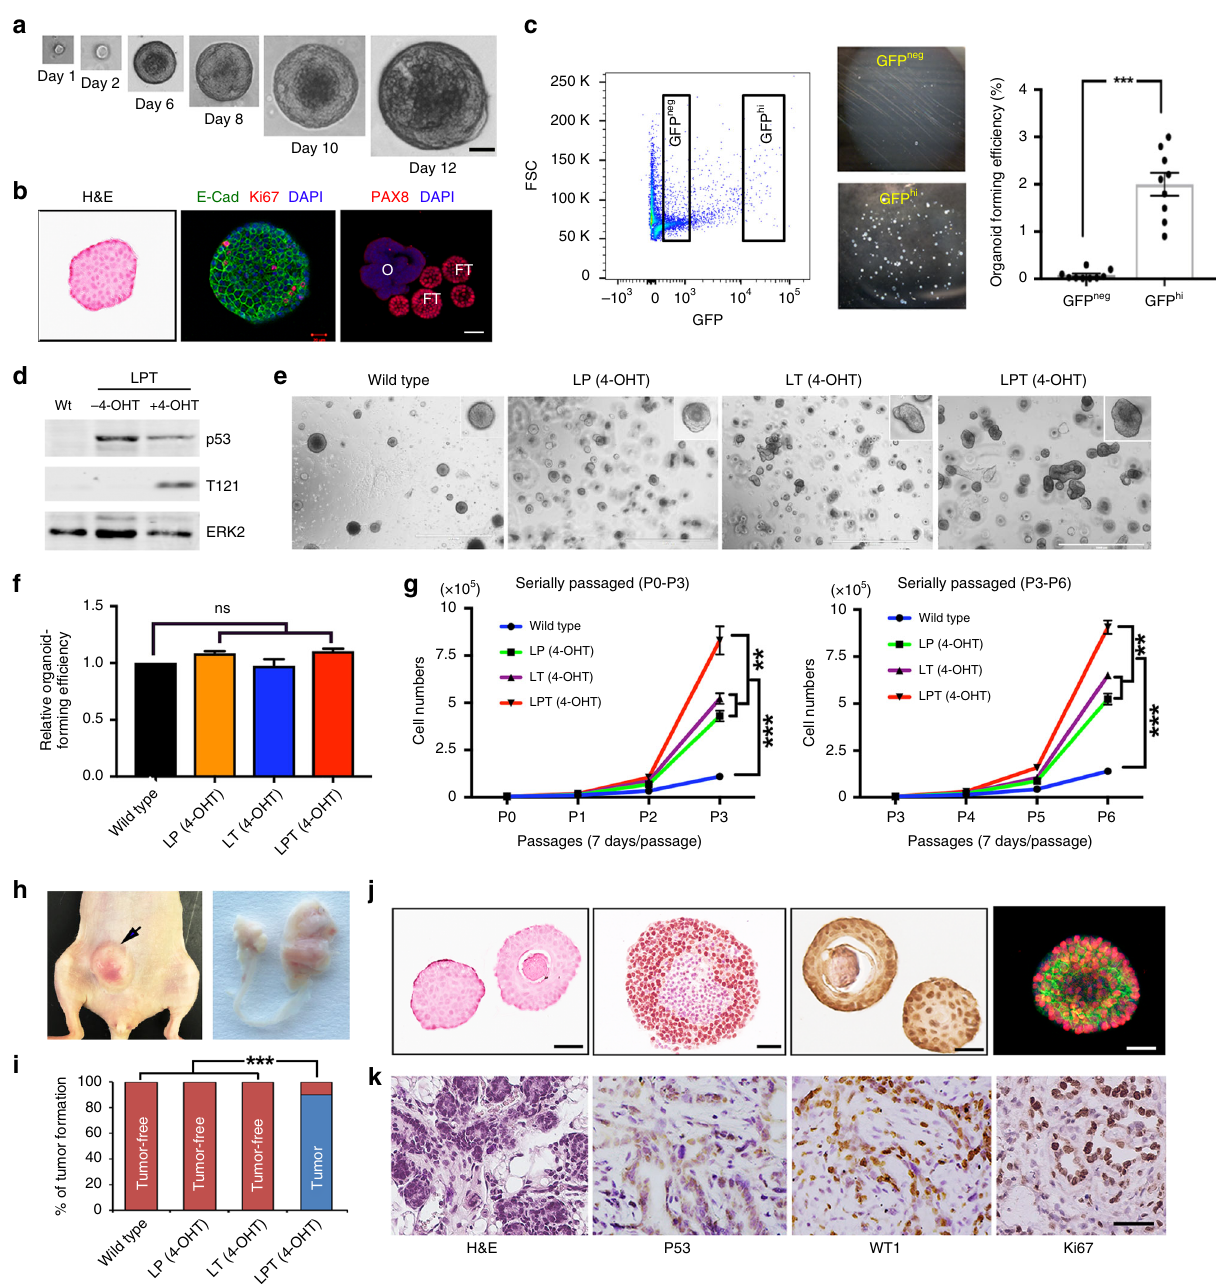
Fig. 6 Transplanted OSE organoids also can give rise to HGSOC. a Representative serial images of OSE organoid at the indicated times after seeding; magni fi cation: ×10, scale bar, 20 μ m. b Left panel: H&E stain of OSE organoid; Middle panel: IF for E-cadherin and Ki67; Right panel: IF for PAX8 in FTE (FT) and OSE (O) organoids. Note that only FTE organoids are strongly PAX8 + . Scale bar, 20 μ m. c Representative fl ow cytometric plot, showing gates used to purify EGFP hi and EGFP neg populations from Lgr5-GFP OSE cells (Left panel). Bright fi eld pictures show organoids that developed from FACS-puri fi ed cells (Middle panel). Right panel shows organoid-forming ef fi ciency of the two populations. Data indicate means± SEM, *** p < 0.001, unpaired t test. d Representative immunoblot for T121 in LPT organoids without 4-OHT treatment and 2 weeks after 4-OHT induction; ERK2 serves as a loading control. Wt: wild type organoid. e Micrographs of typical OSE organoids from mice of the indicated genotypes after 6 days culture. f Relative organoid-forming ef fi ciency of OSE cells from mice of the indicated genotypes; Data represent means± SEM; ns not signi fi cant, Tukey ’ s multiple comparison test. g Growth curves of OSE organoids from the indicated mice; Cells per well were counted at each passage from P1 – P3 and P4 – P6. Organoids from three independent mice for each group were used, each in duplicate. (Source data are provided as a Source Data fi le.) Data represent means ± SEM, ** P < 0.01, *** P < 0.001, two-way ANOVA. h Gross pictures of OSE organoids transplanted into the MFP (left panel, 5 months post-injection of 10 5 OSE organoid cells) or the ovarian bursa (right panel, 4 months post-injection of 10 5 OSE organoid cells) of nu/nu mice. i % of tumors formed in mice within 6 months after injection of 10 5 cells from wild type, LP, LP, or LPT organoids (all 4-OHT-treated), n = 10 mice/group; *** P < 0.001, Fischer ’ s exact test. j and k Representative H&E staining and IHC for the indicated markers in LPT organoids (top) and the orthotopic tumors derived from these organoids, 4-months post injection of 10 5 cells